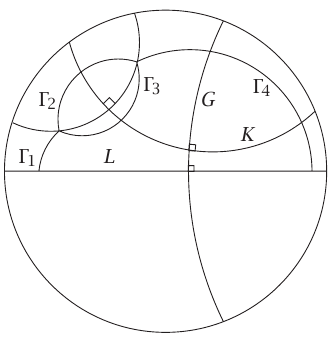
Figure 7.8 . Using a hyperbolic isometry to show that a nonstandard bubble in H n where each region is connected is